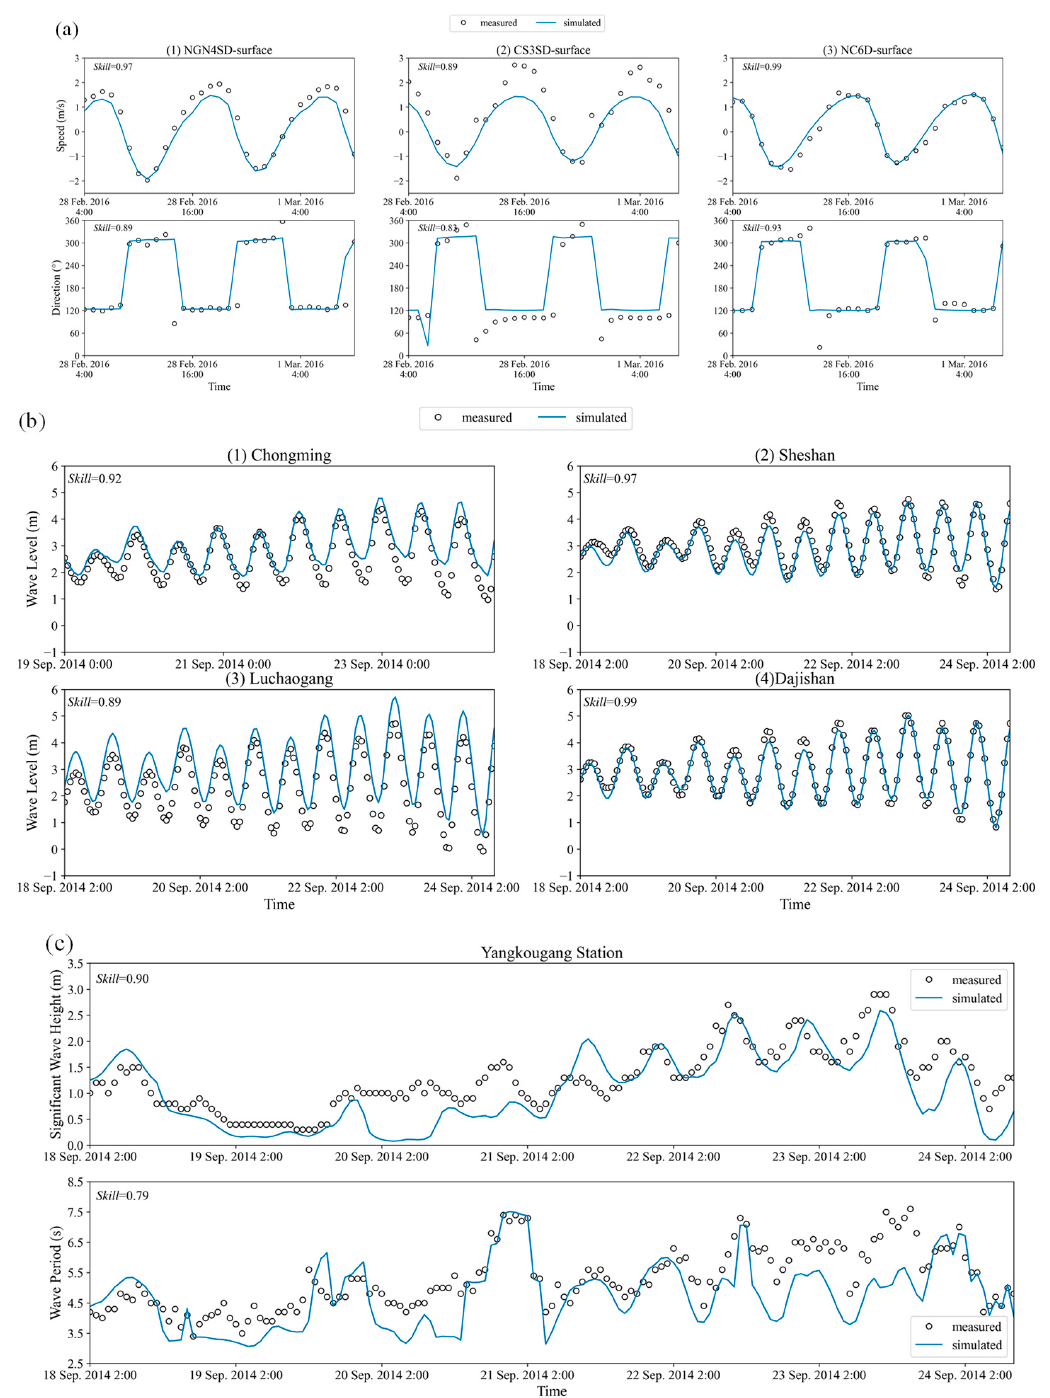
Figure 3. The verification of ( a ) current speed and direction; ( b ) water level and ( c ) significant wave height and wave period.